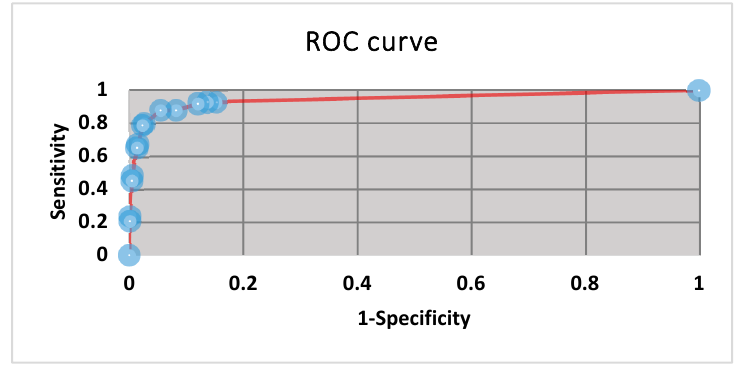
Figure 1. Receiver operating characteristic curve generated from 14 cut-off values, indicating the best positive cut off values to be between 1/60 and 1/80 dilutions. The area under the curve is 0.94.